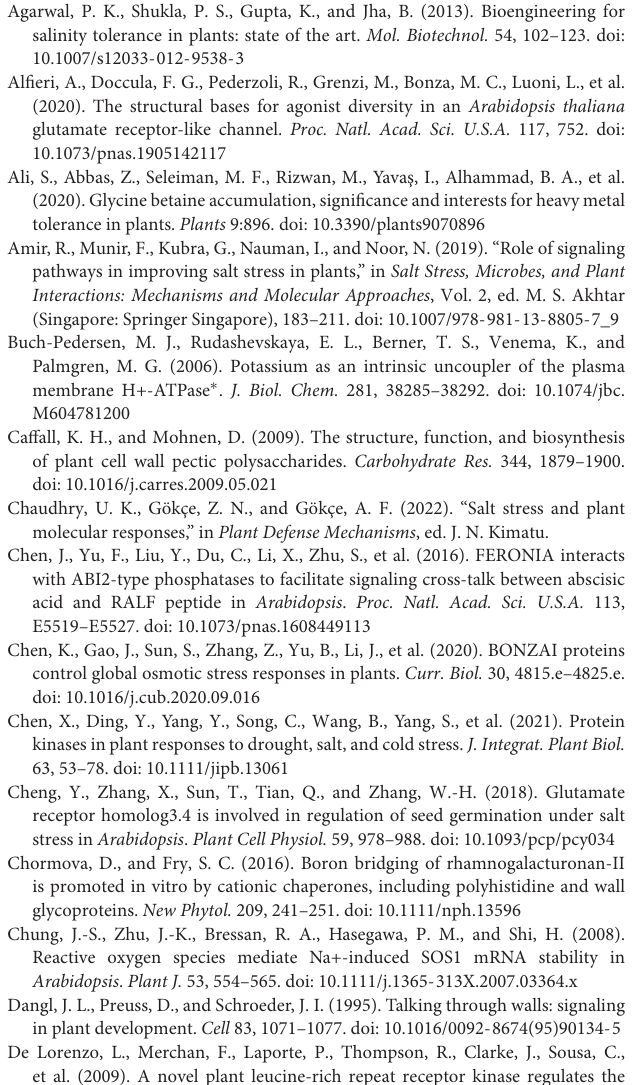
Supplementary Figure 1 | 3D structure prediction of some possible sensors and receptors by AlphaFold in Arabidopsis thaliana . The possible sensors and receptors: (A) Annexin D1 (ANN1); (B) Sodium/calcium exchanger NCL (NCL);